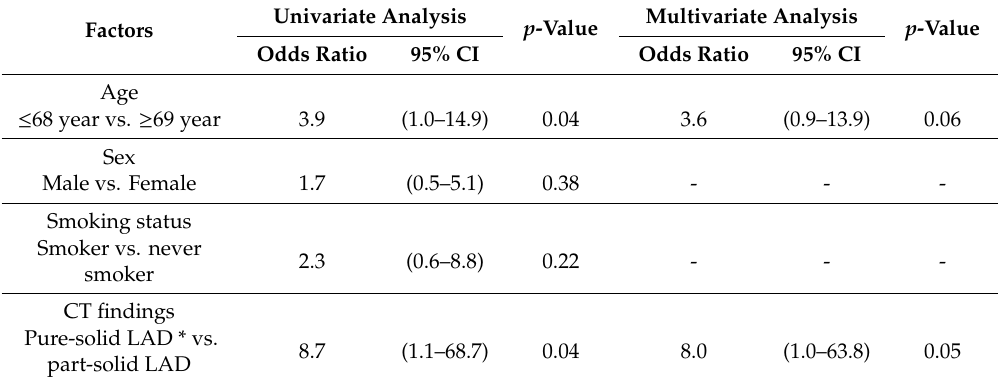
Table 3. Univariate and multivariate analyses for factors related to high PD-L1 + TPS ( ≥ 50%).